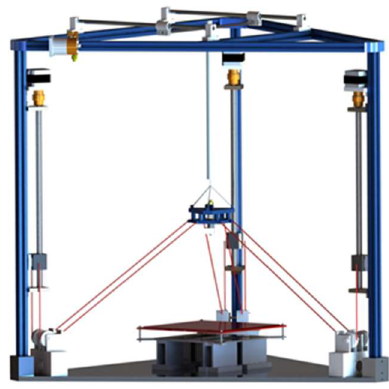
Figure 1. Three-dimensional (3D) model of the cable-driven parallel robot (CDPR) for 3D Printing.